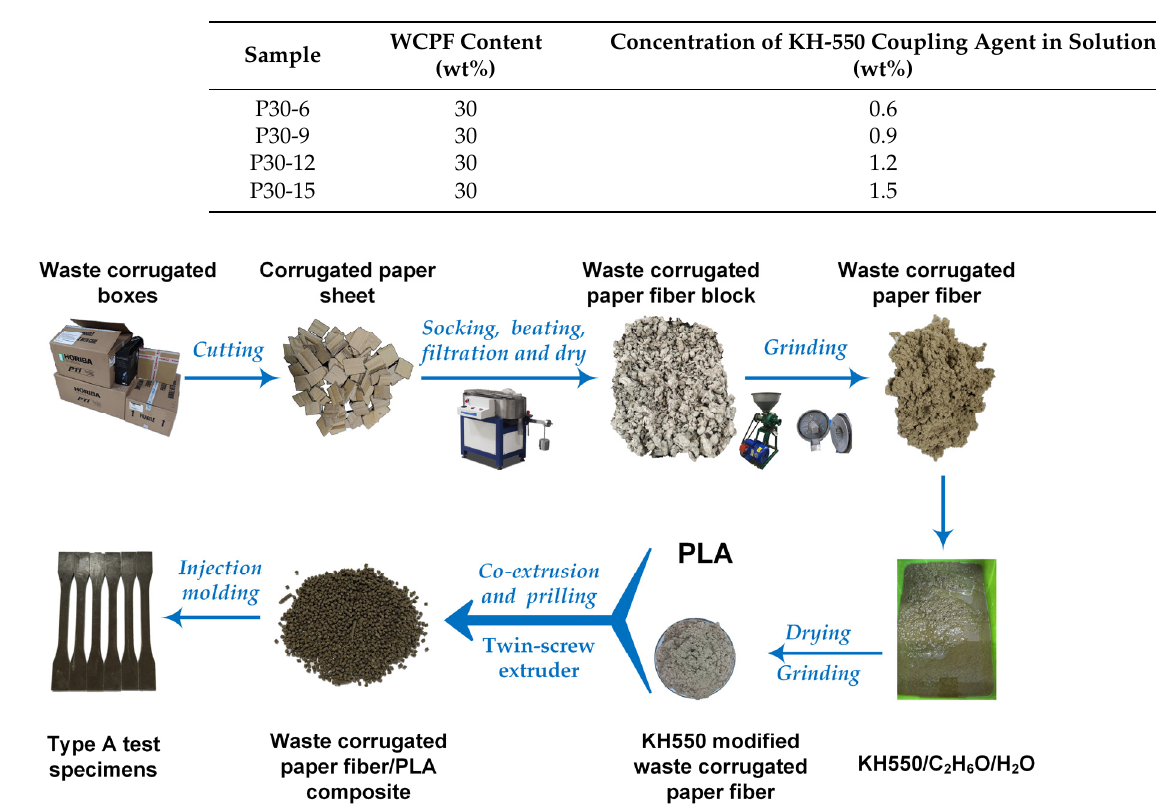
Figure 1. Preparation process diagram of the WCPF/PLA composite. Table 1. The raw material ratio of the WCPF/PLA composite.